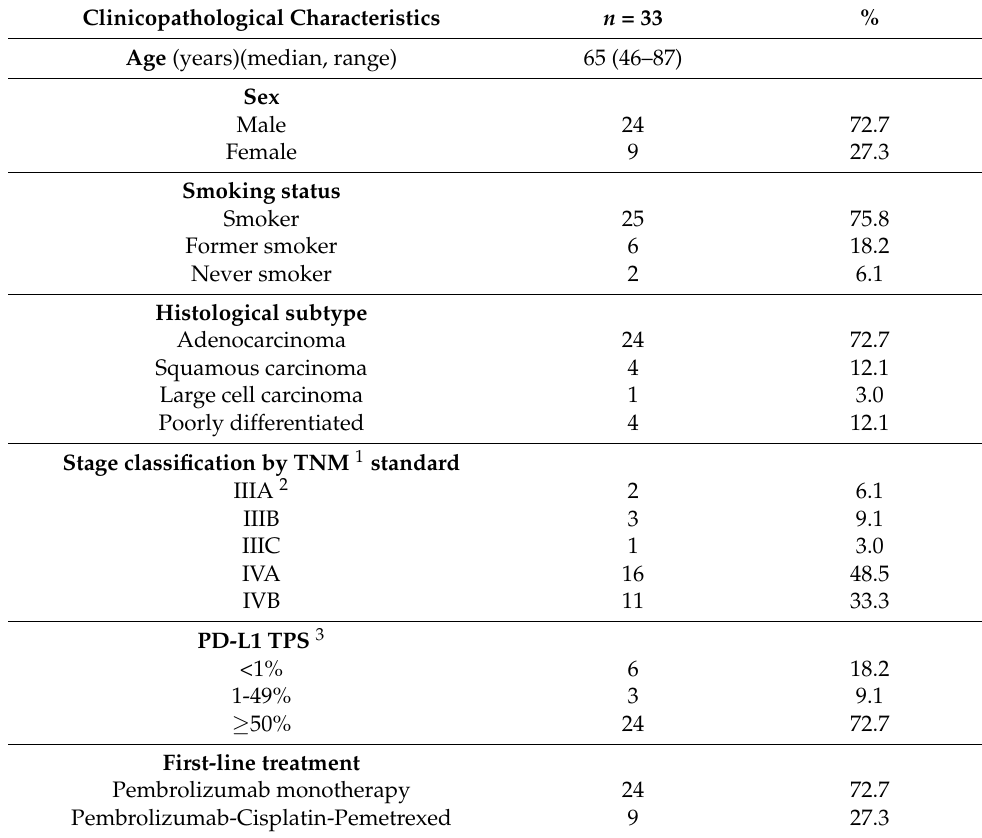
Table 1. Clinicopathological characteristics of the patients included in the